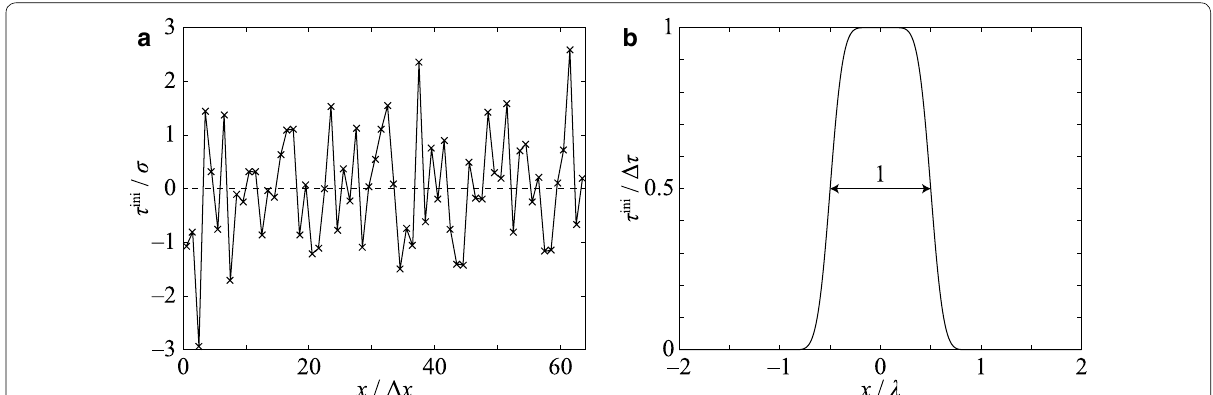
Fig. 2 Distributions of τ ini assumed in the numerical experiments. a A Gaussian random distribution for 64 elements for numerical stability analysis. b A smooth boxcar-like function (Eq. 18), which was sampled by elements of (cid:31) x from (cid:31) to (cid:31) /